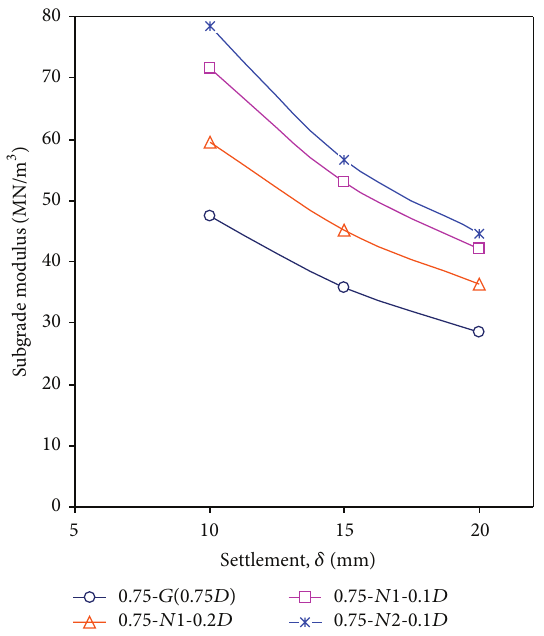
Figure 19: Subgrade modulus for Series III ( 𝐷 = 0.75 𝑀 ), compari-